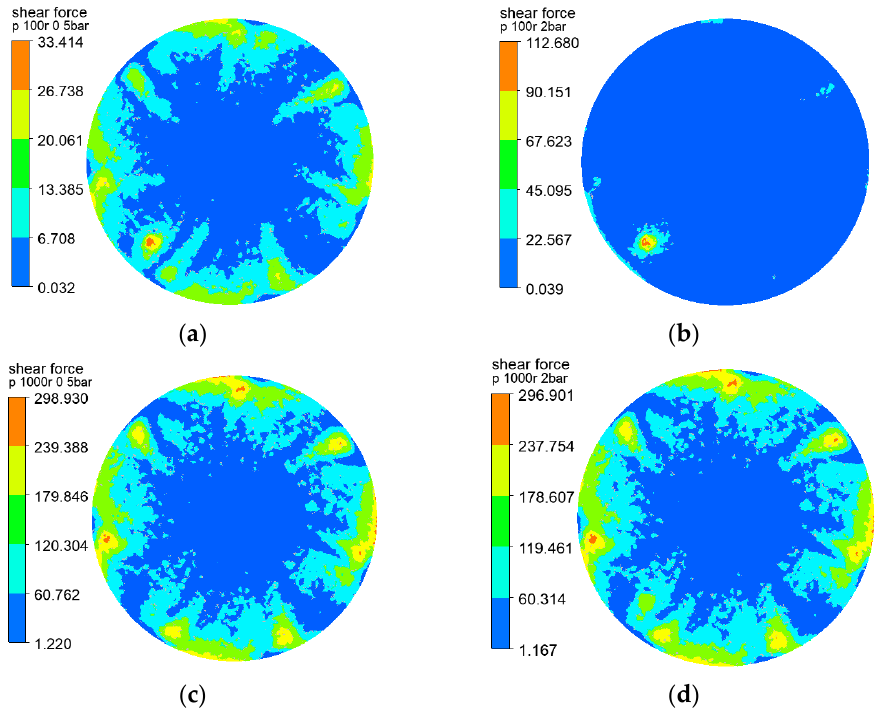
Figure 6. Cloud charts of shear force on the membrane surface when the propeller is at different rotating speeds and pressures: ( a ) r = 100 r/min, △ P = 0.5 bar ( b ) r = 100 r/min, △ P = 2 bar ( c ) r = rotating speeds and pressures: ( a ) r = 100 r/min, (cid:52) P = 0.5 bar ( b ) r = 100 r/min, (cid:52) P = 2 bar 1000 r/min, △ P = 0.5 bar ( d ) r = 1000 r/min, △ P = 2 bar. ( c ) r = 1000 r/min, (cid:52) P = 0.5 bar ( d ) r = 1000 r/min, (cid:52) P = 2